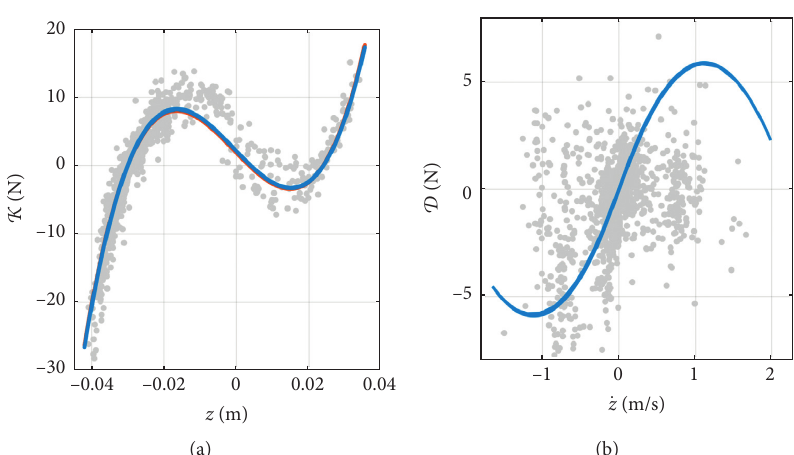
Figure 22: Estimation of the restoring force K ( z ) (a) and the damping force D ( _ z ) (b). Gray dots: sliced restoring surface; orange line: RFS estimation (only in a); blue line: NSI estimation.